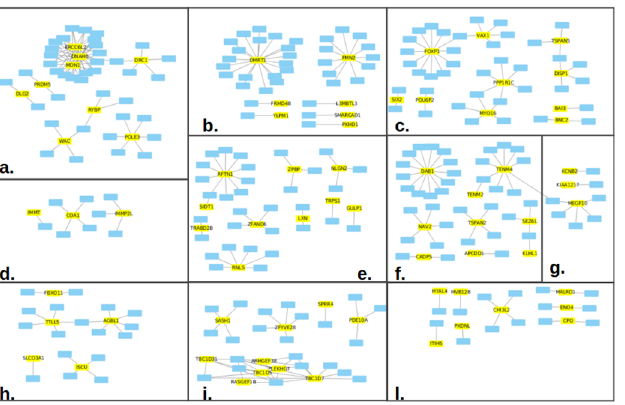
Fig 3. Overview of the GO biological processes exclusively linked to genes without pathways. The image represents 248 GO biological processes (blue rectangles) linked with 74 genes without pathways (yellow rectangles). The processes are grouped in ten frames according to similar functions. Each group is identified with the highest level GO term that identifies the general action of the processes. a. DNA modification ( e.g. : histone methylation, acetylation and ubiquitination, and G1 DNA damage checkpoint) and ATP metabolism processes such as purine ribonucleoside metabolic processes; b. Cytokinesis and different types of regulation of meiotic cell cycle regarding: sex determination, chromosome separation, telomere maintenance and polar body extrusion; c. Stem cell fate determination; d. Mitochondrial metabolism such as: cytochrome complex assembly and mithocondrial protein processing; e. Cell communication regarding: protein targeting and transport, cell-cell junction maintenance, membrane raft assembly, and immune system processes such as: T cell antigen processing and pattern recognition of the toll-like receptor 3; f. Brain development regarding: astrocyte, microglia, glial, myelin and synapse maturation; g. Skeletal muscle development; h. Protein modification i.e . methylation, acetylation,poly- and de-glutamylation); i. Several signaling cascades related to: cGMP catabolic process, epidermal growth factor-activated receptor activity, kinase A, TOR, GTPase, NIK/NF-kappaB, and keratinization; l. Metabolic processes especially chitin and hydrogen peroxide catabolic processes, ubiquitin dependent protein, bile regulation, thyroid hormon generation, and glycolytic process).